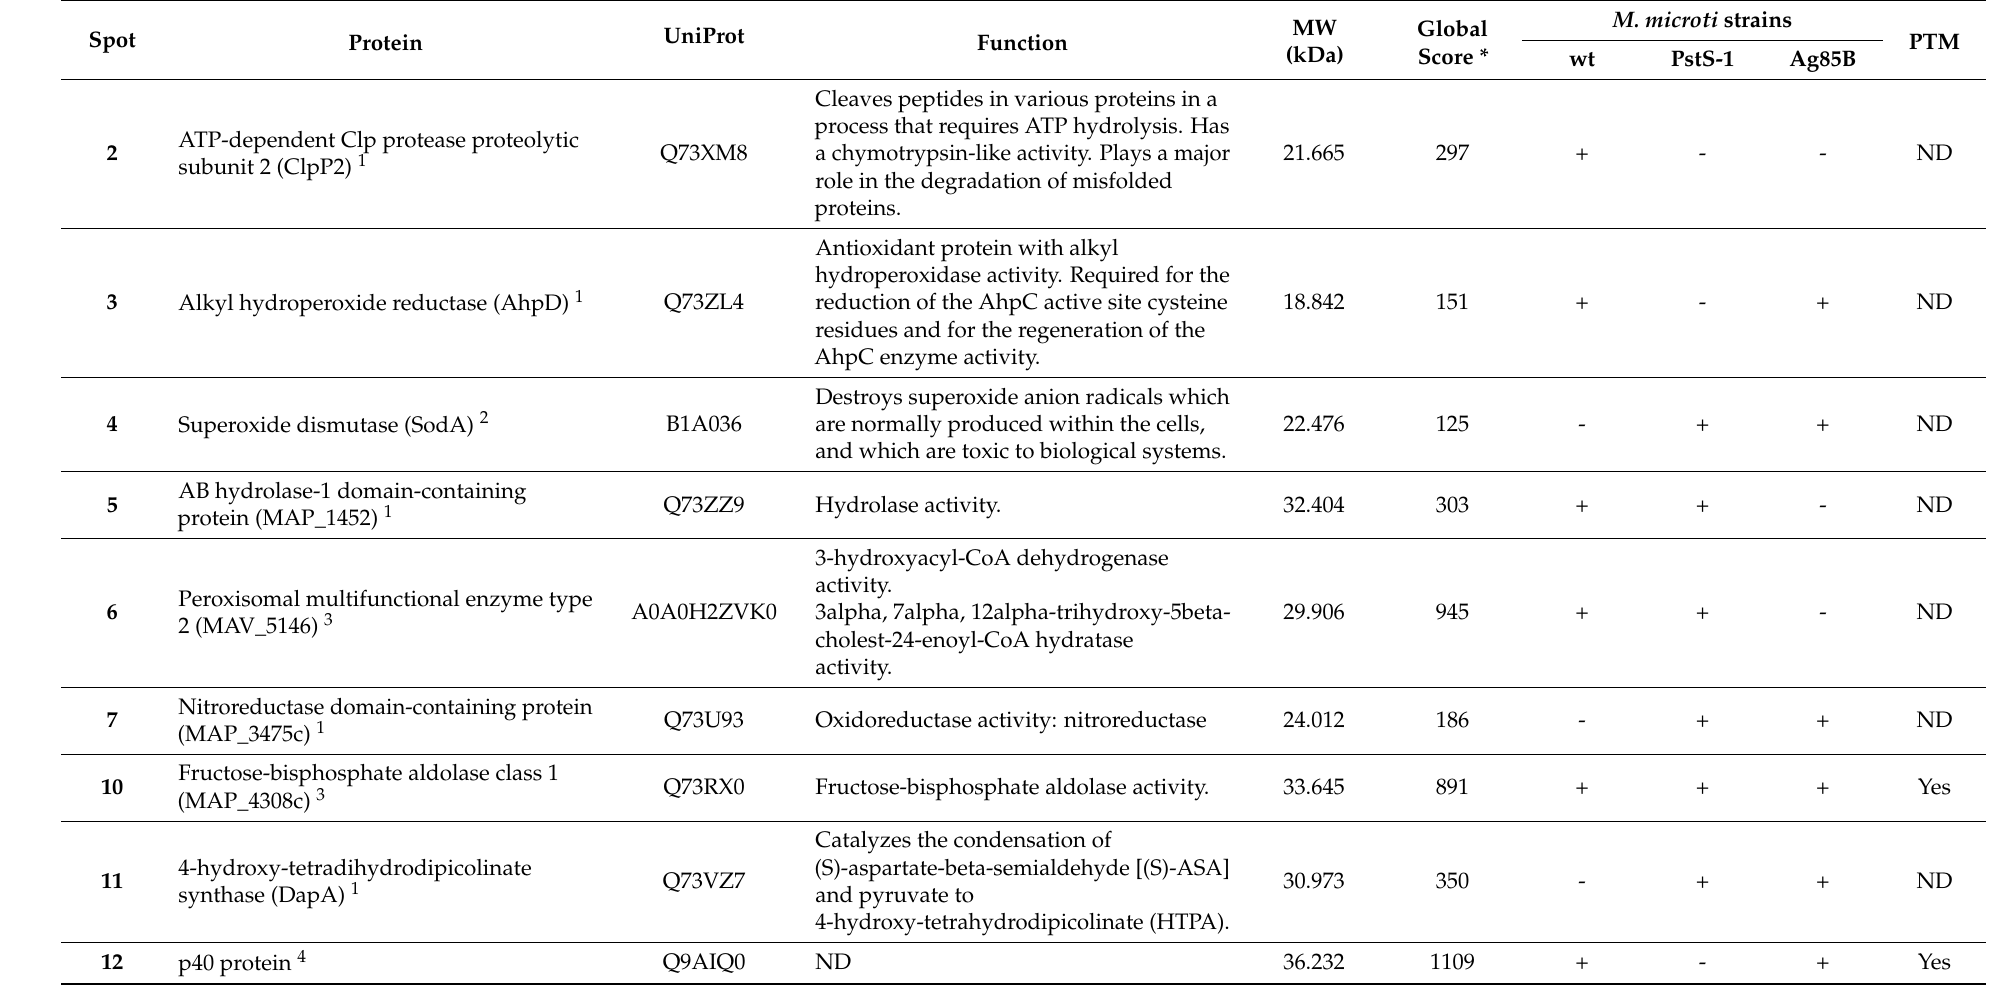
Table 2. Proteins identified by MS/MS from M. microti